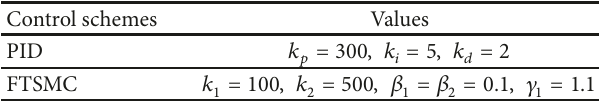
Table 1: Controllers’